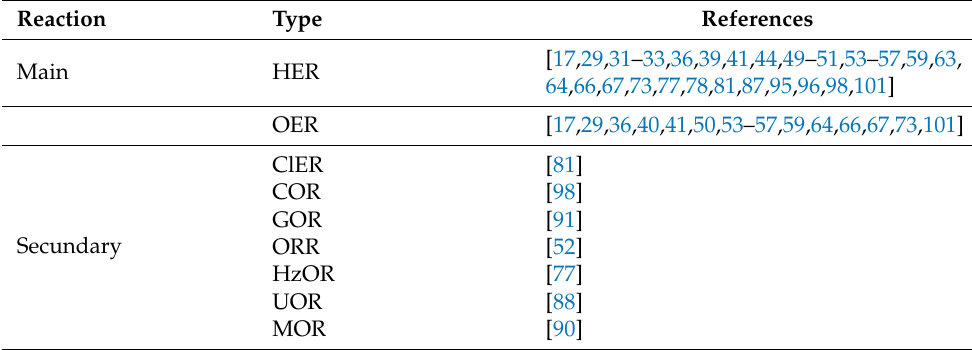
Table 3. Possible electrochemical reactions at seawater electrolysis. Reaction